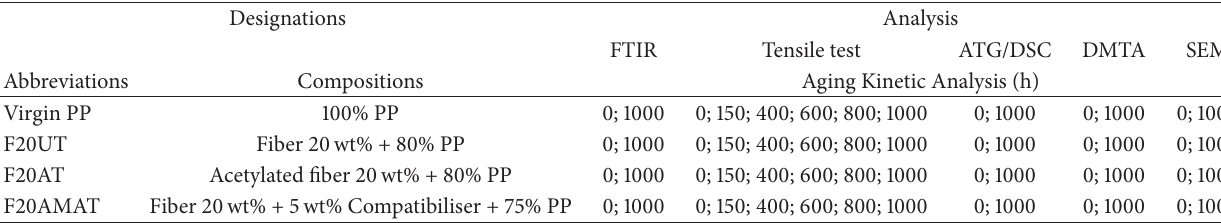
Table 1: Overview of the samples